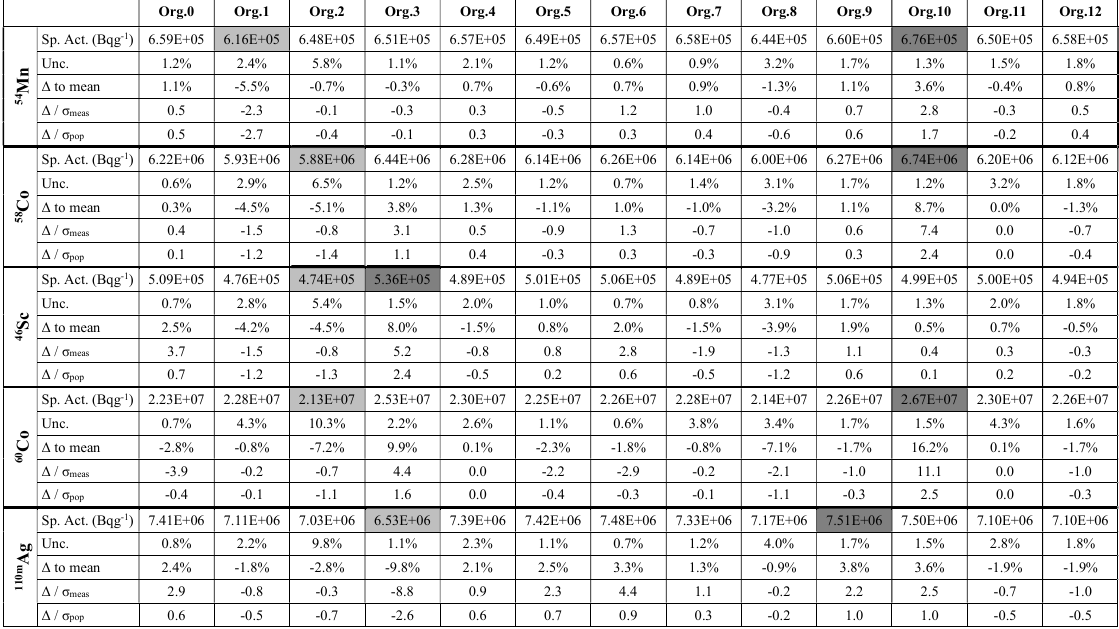
Table 2 Details of Specific Activity Measurements Provided by Each Participant (note: maximum and minimum values identified in grey shade, maximum values with white text) Org.0 Org.1 Org.2 Org.3 Org.4 Org.5 Org.6 Org.7 Org.8 Org.9 Org.10 Org.11